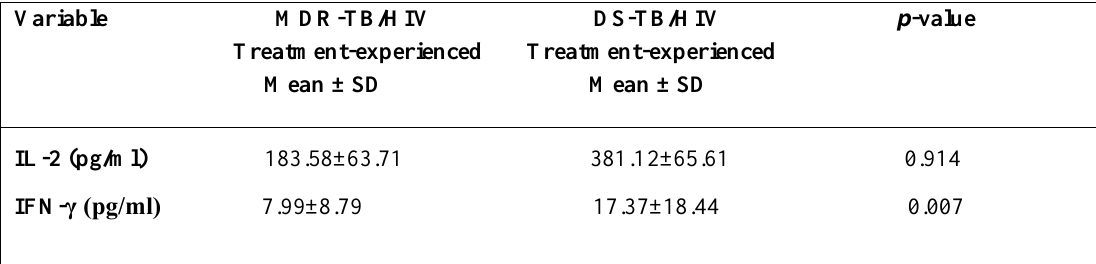
Table 6. Comparison between MDR -TB/HIV and DS -TB/HIV